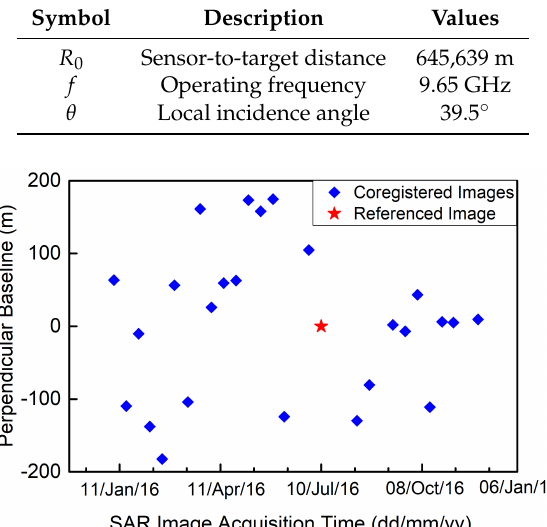
Table 1. Parameters of TerraSAR-X.